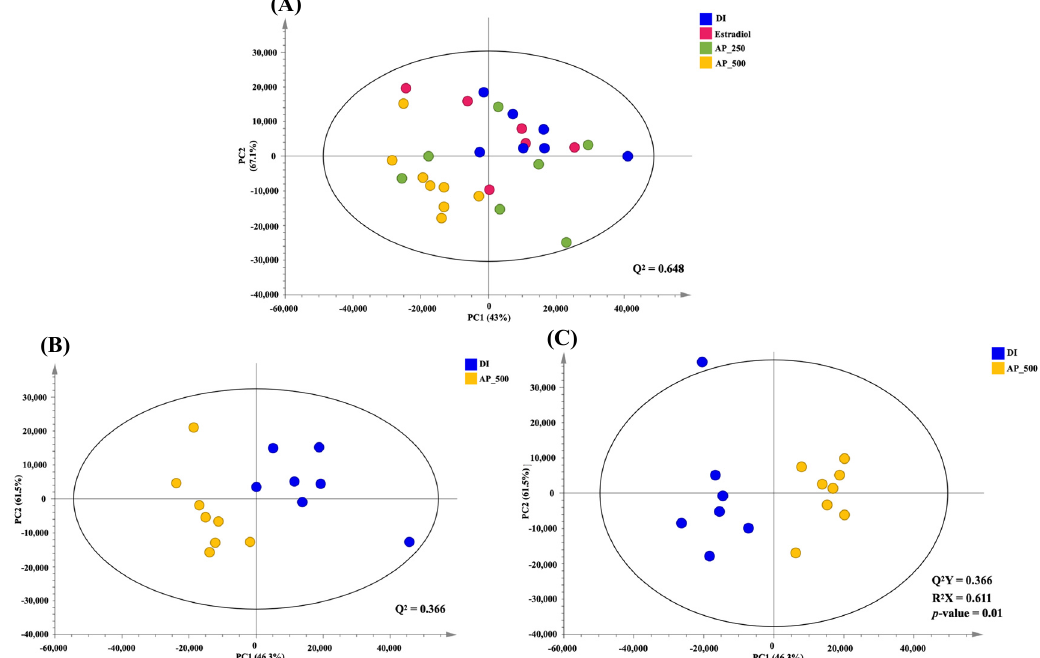
Figure 6. PCA score plot of all interventions; blue = DI water, pink = E2, green = AP extract 250 mg/kg/day, yellow = AP extract 500 mg/kg/day ( A ). PCA score plot between control (DI water) and AP 500 group ( B ). OPLS-DA score plot between control (DI water) and AP 500 ( C